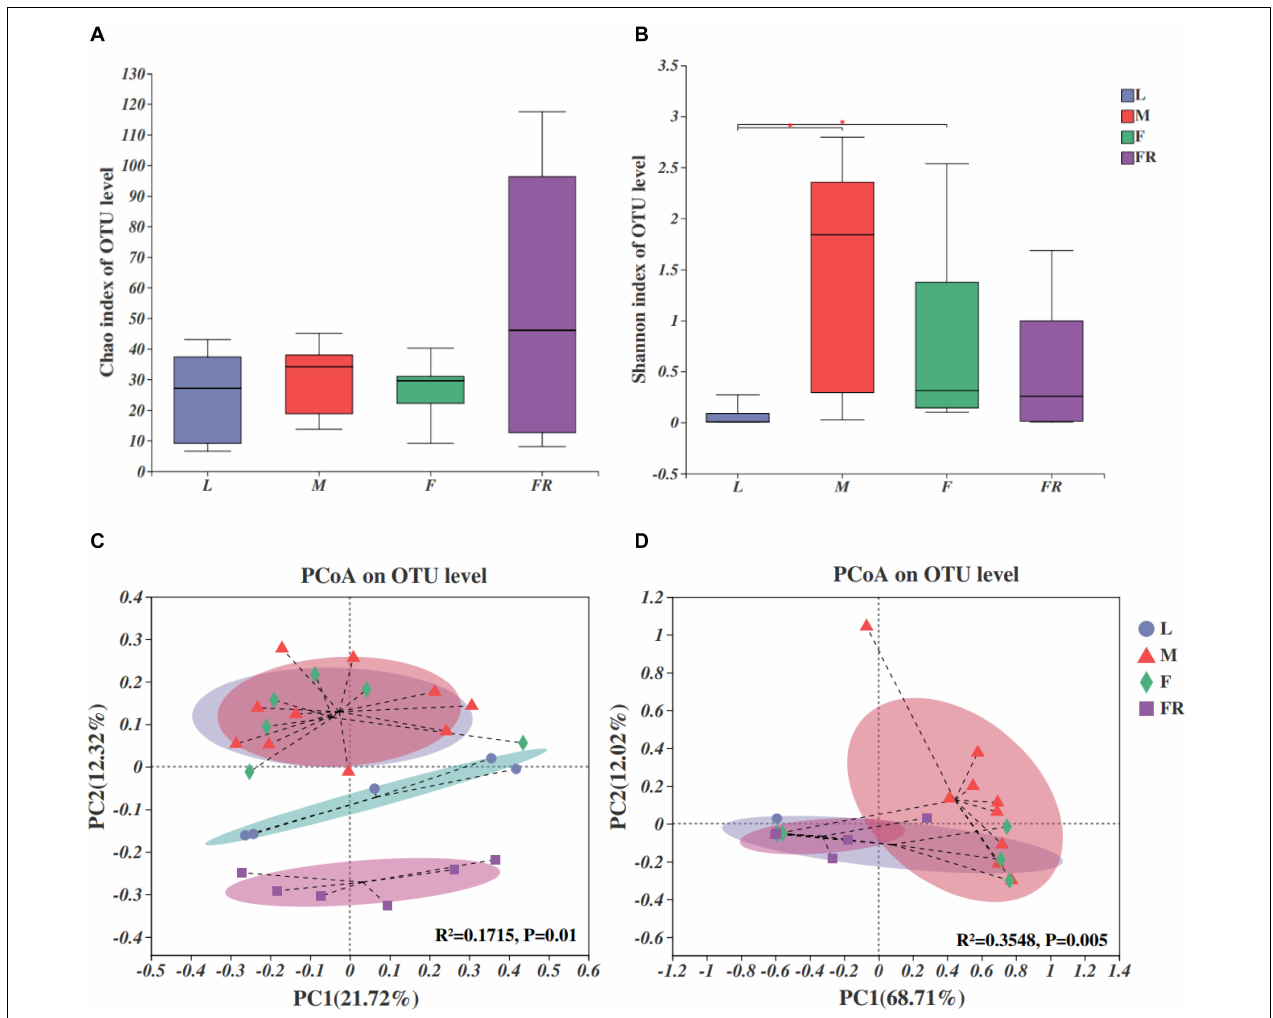
FIGURE 4 | Fungal communities in the Sirex noctilio gut and frass. Boxplots of (A) species richness (Chao index), and (B) species diversity (Shannon index). The significant differences of alpha diversities were analyzed using Wilcoxon rank-sum test ( ∗ 0.01 < P ≤ 0.05). (C) Unweighted and (D) weighted UniFrac-based PCoA plots of fungal communities. The significant differences in beta diversities were analyzed using adonis analysis with 999 Monte Carlo permutations (L, larva; F, female; M, male; and FR,